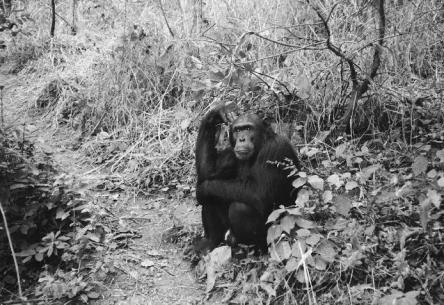
Analyzing "pseudogenes" that lost their functionality since humans and chimps diverged over 6 million years ago promises to shed light on the genetic basis of human origins. (Photo: Curt Busse, Gombe National Park, Tanzania)